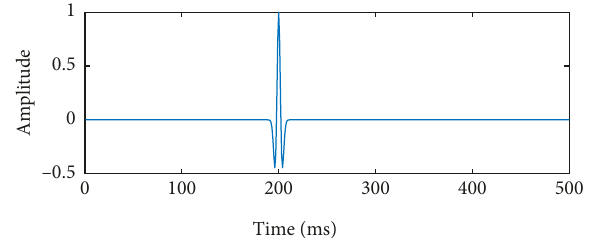
Figure 2: Ricker wavelet signal